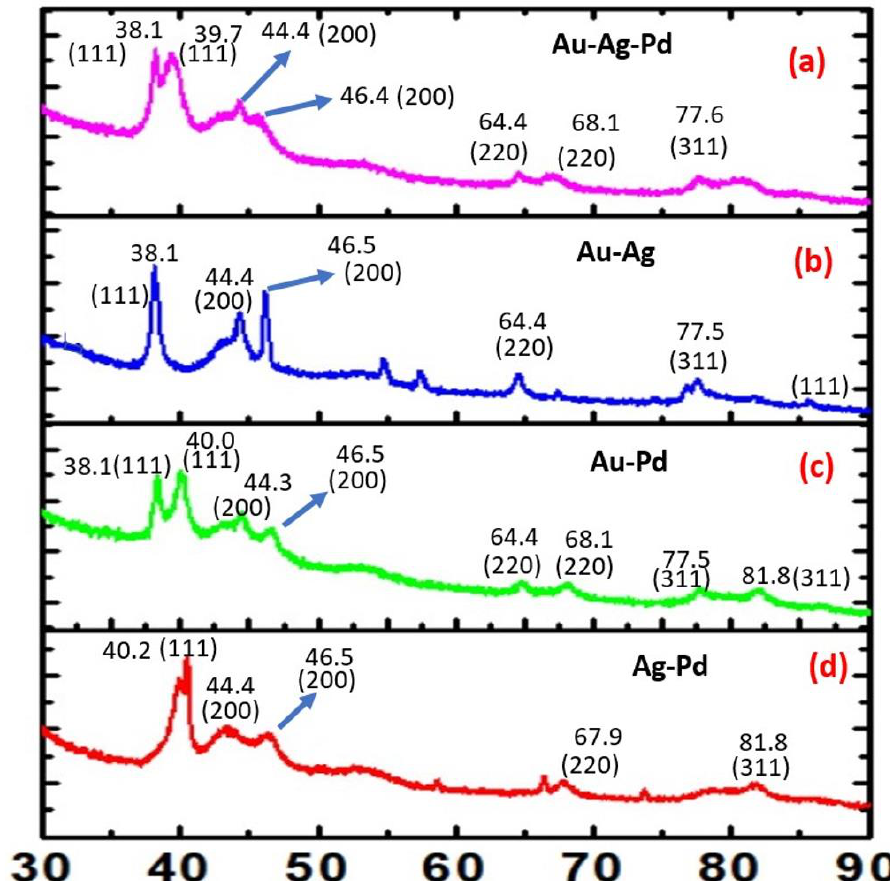
Figure 3. XRD profile of ( a ) trimetallic (Au-Ag-Pd) NPs, ( b ) bimetallic (Au-Ag) NPs, ( c ) bimetallic (Au-Pd) NPs, and ( d ) bimetallic (Ag-Pd) NPs.